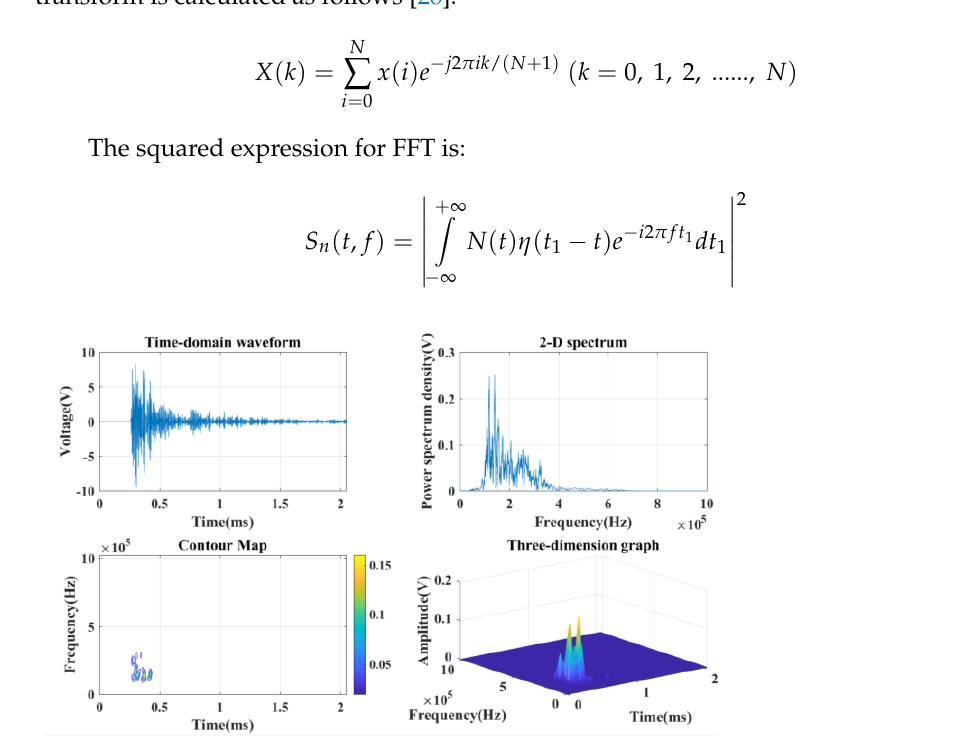
Figure 7. Time – frequency feature map. Figure 7. Time–frequency feature